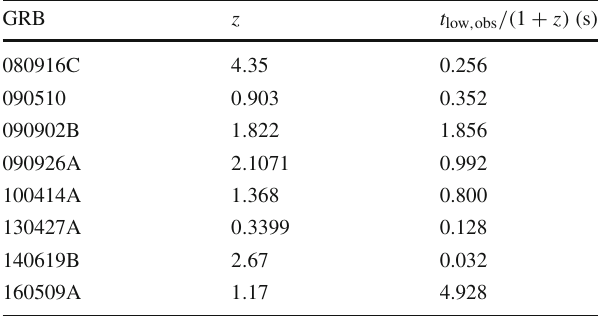
Table 4 t low , obs /( 1 + z ) determined by the average energy crite-